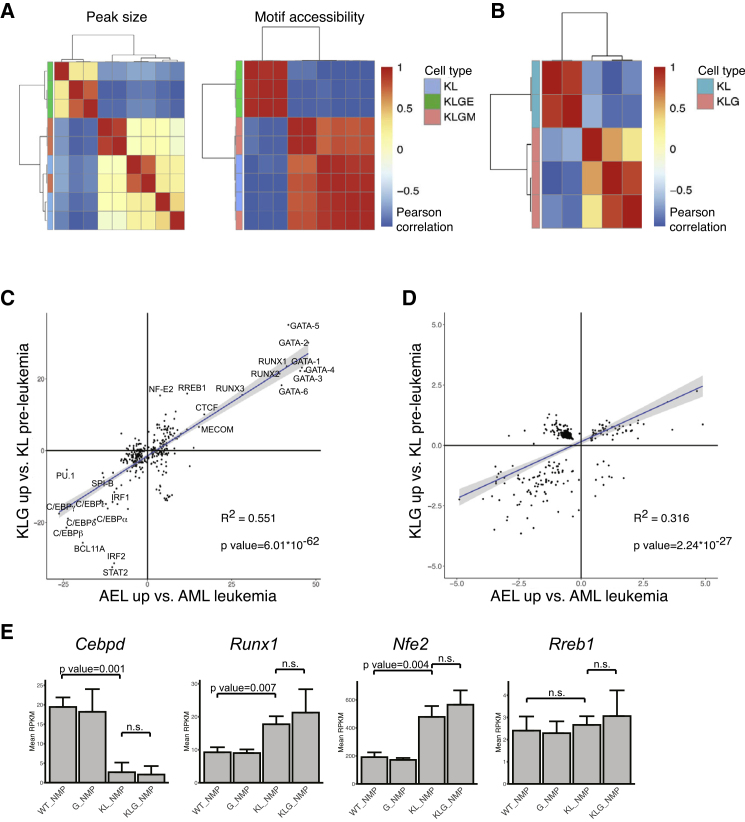
Mutation of GATA-2 ZnF1 Induces an Erythroid-Permissive Chromatin State(A) Leukemic KL, KLG-M, and KLG-E L-NMP were hierarchically clustered using Pearson correlation of ATAC sequencing peak intensities (left panel) and motif accessibility (right panel). n = 3 per genotype.(B) Pre-leukemic KL (n =3) and KLG NMP (n = 2) samples were hierarchically clustered using Pearson correlation of motif accessibility.(C) Plot showing linear modeling of the correlation between TF motifs with significantly different accessibility in AEL versus AML L-NMPs, samples from (A, x axis) and KL versus KLG NMPs, samples from (B, y axis). The linear model and associated R2 and p values are shown.(D) Plot showing linear modeling of the correlation between promoters with significantly different accessibility as in (C).(E) Expression of genes encoding cognate TFs for correlated motifs from (C) measured as in Figures 5C–5E. TFs already included in Figures 5C–5E are not shown. Values are mean RPKM ± SD, n = 3 per genotype.See also Tables S5 and S6.